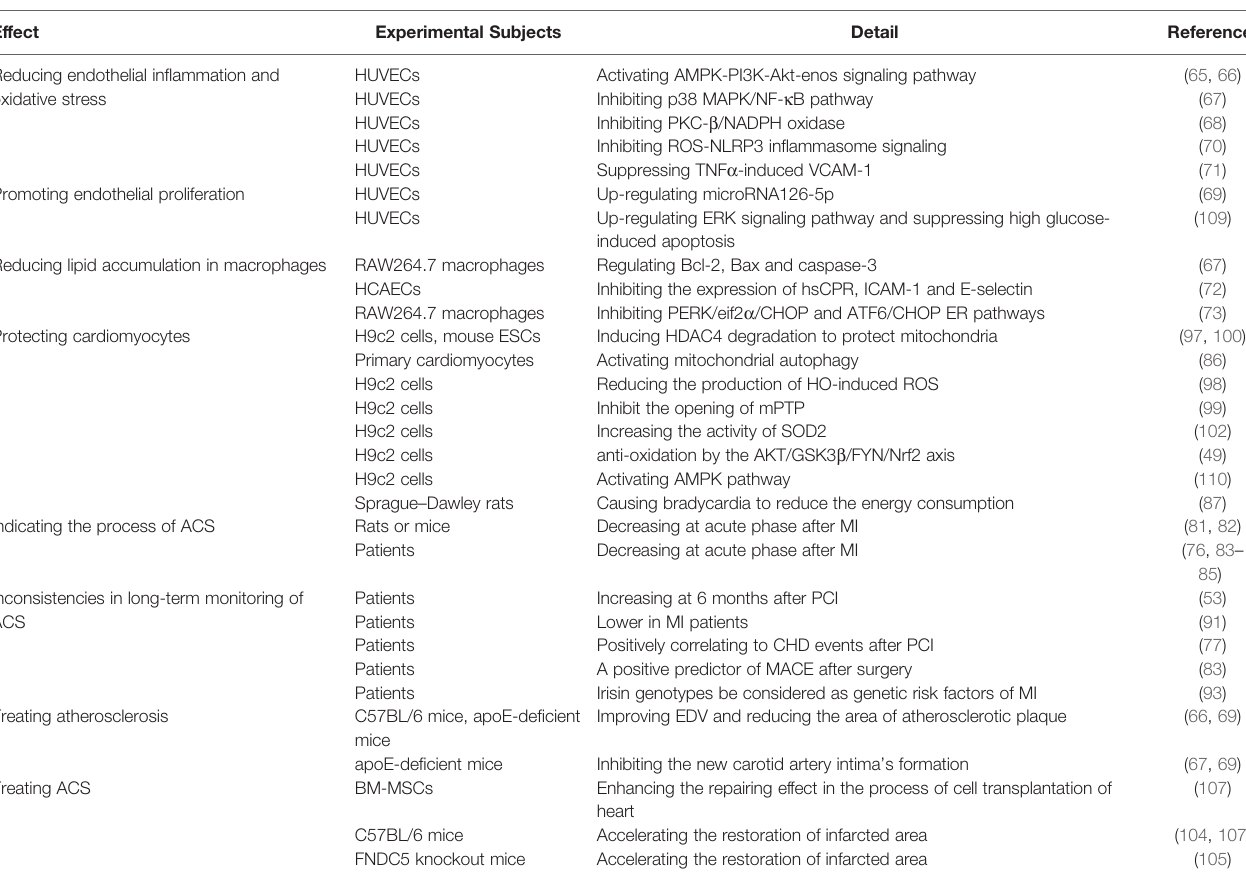
TABLE 1 | Functions of Irisin in